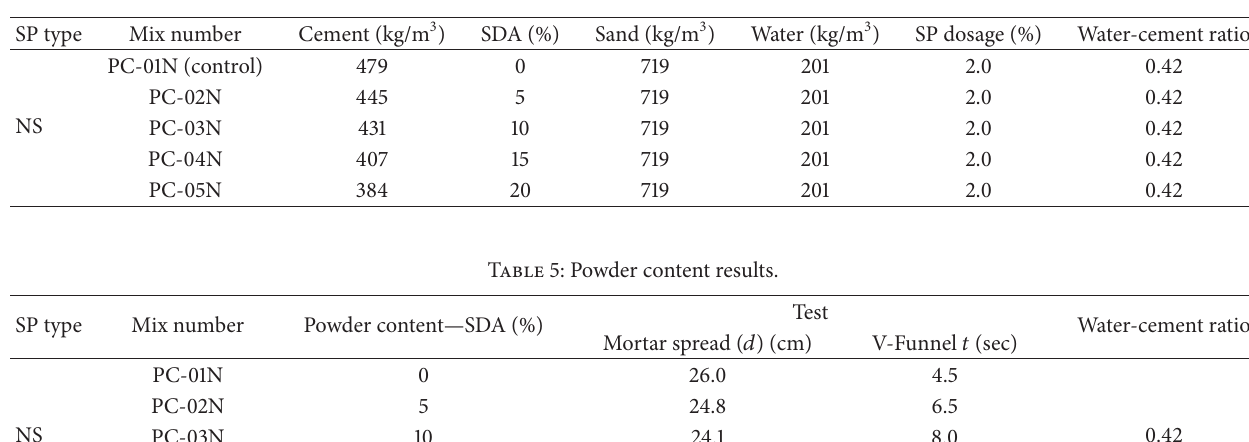
Table 4: Mixture proportions for the powder content test.